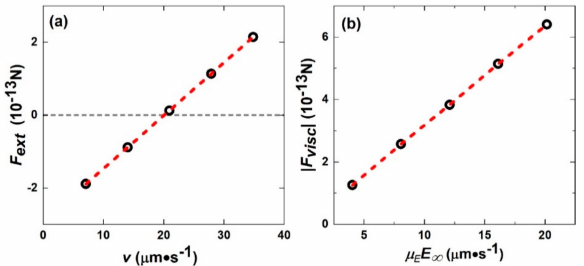
Figure 8. The di ff erence between γ S and γ E . ( a ) The external force F ext at the inner / outer interfacial region shows a linear dependence with the relative velocity v between the sphere and simulation boundary (infinity). The open circles indicate five di ff erent values of v . The red dashed line denotes the best fitting with a slope of 1.45 × 10 − 8 kg · s − 1 , which is very close to the Stokes drag coe ffi cient 1.41 × 10 − 8 kg · s − 1 ( = 6 πη a, 3% lower than the slope). The external force becomes zero when v is exactly at the electrophoretic velocity. The external electric field strength was maintained at E ∞ = 500 V / m. ( b ) The viscous force F visc at the inner / outer interfacial region with a relative velocity v = µ E E ∞ between the sphere and the liquid at the simulation boundary (infinity). The external electric field strength was varied from 100 V / m to 500 V / m in 100 V / m steps. The red dashed line indicates fitting with a slope of 2.9 × 10 − 8 kg · s − 1 ( = 2.1 × 6 πη a ). All simulations were performed with a surface charge density of S = − 7 × 10 3 e / µ m 2 , radius of a = 0.75 µ m and ionic strength of 0.01 mM ( λ D = 100 nm). Adapted from